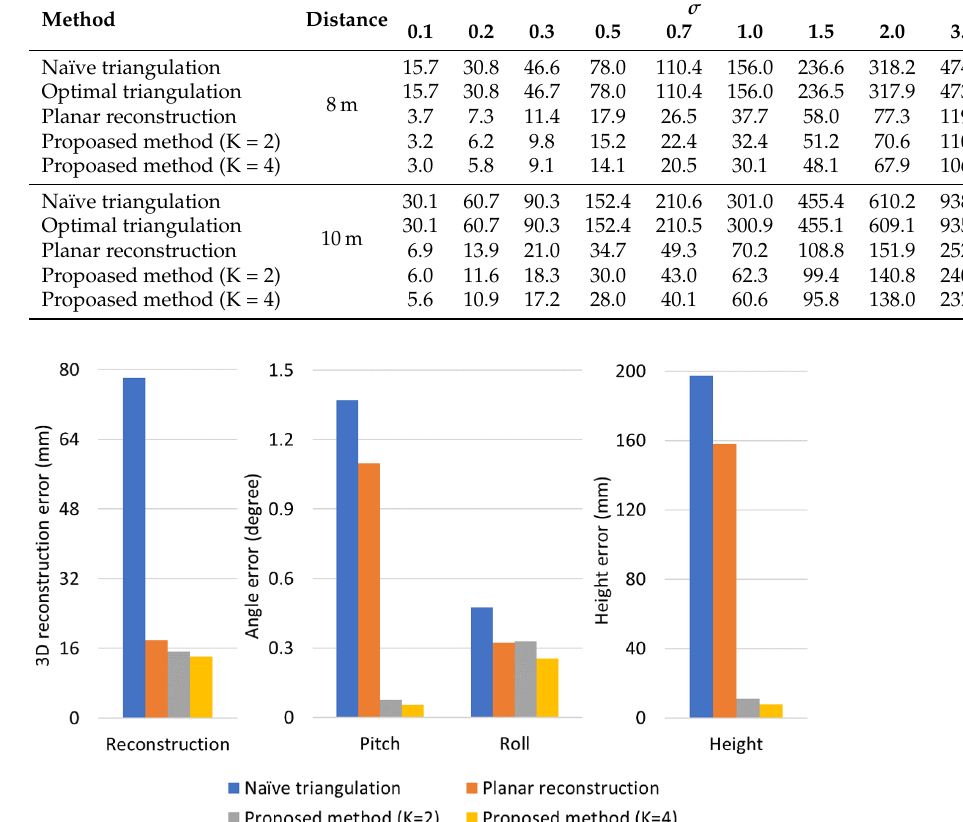
Table 1. Reconstruction errors (mm) with respect to various amounts of pixel noise.